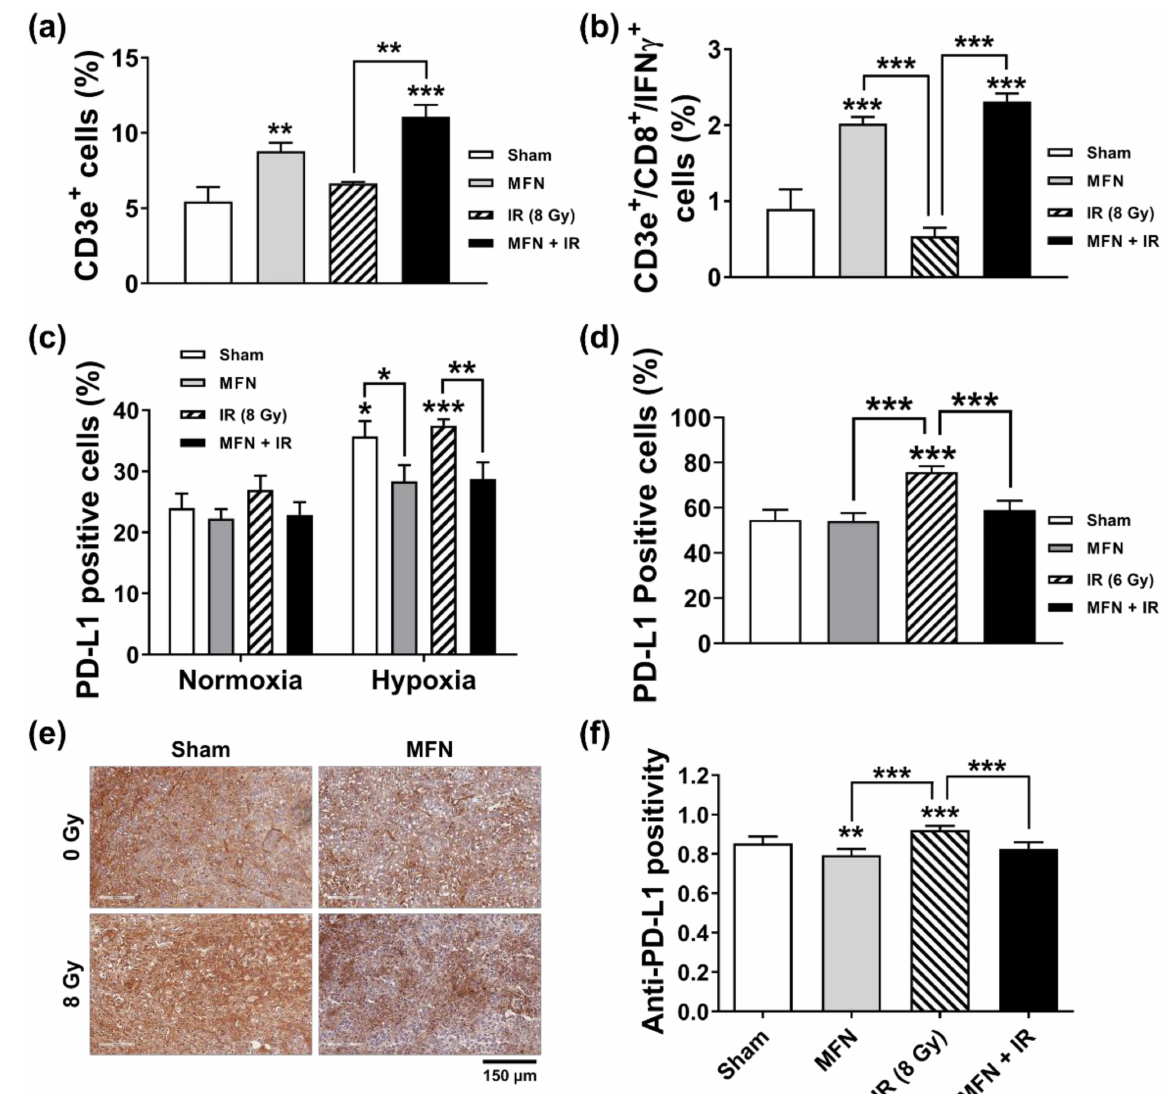
Figure 6. Modulation of T-cell infiltration and PD-L1 expression by MnFe 2 O 4 nanoparticles (MFN). ( a ) MFN promoted the infiltration of CD3e+ T cells in tumor tissues harvested on day 30. ( b ) MFN increased the percentage of cytotoxic CD3e+/CD8+/IFN γ + T cells following treatment with 8 Gy of ionizing radiation (IR) and intratumoral injection of MFN. ( c ) Flow cytometric analysis showed that MFN suppressed the hypoxia-induced PD-L1 expression in Hepa1-6 cells. Hepa1-6 cells were pre-incubated with 5 µ g/mL of MFN under hypoxic or normoxic conditions, followed by 8 Gy of IR. ( d ) Flow cytometric analysis showed that MFN suppressed the radiation-induced PD-L1 expression in cells collected from tumor tissues. ( e ) Immunohistochemical analysis of PD-L1 expression in tumor tissues. ( f ) Comparison of PD-L1 positivity in the tumor tissues among the experimental groups. The values represent the mean ± SD; * p < 0.05; ** p < 0.01; *** p <